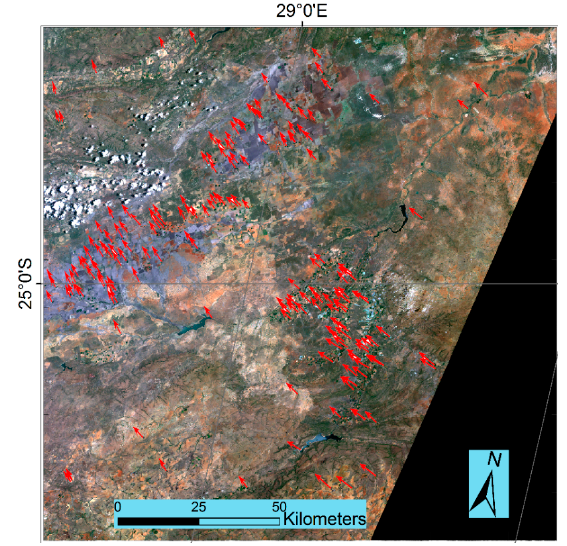
Figure 8. Illustration of the tie-points and misregistration vectors obtained from the Limpopo data (Figure 2). The vectors point from the Landsat-8 week 49 image tie-point locations to the Sentinel-2A week 49 (180 red vectors) tie-point locations. The vector lengths are enlarged by 200 times for visual clarity. To provide geographic context the background image shows the Landsat-8 week 49 30 m true color image. Table 6. Summary statistics (units 10 m pixels) of the Limpopo (Figure 2) Landsat-8 week 49 and